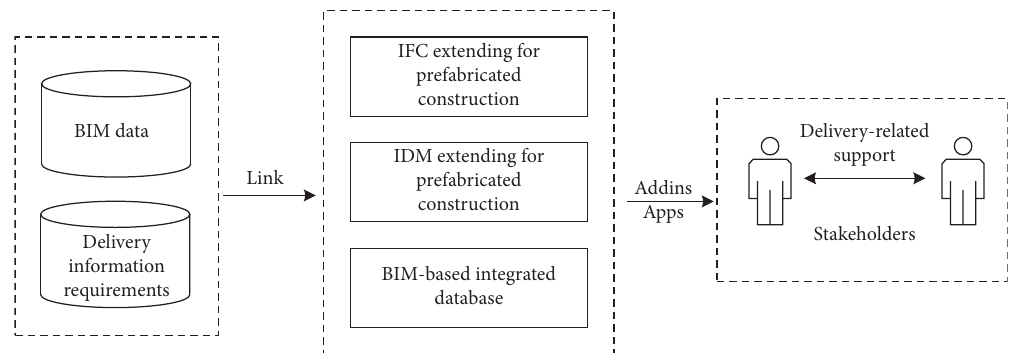
Figure 9: Overview of BIM-based data integration of prefabricated construction